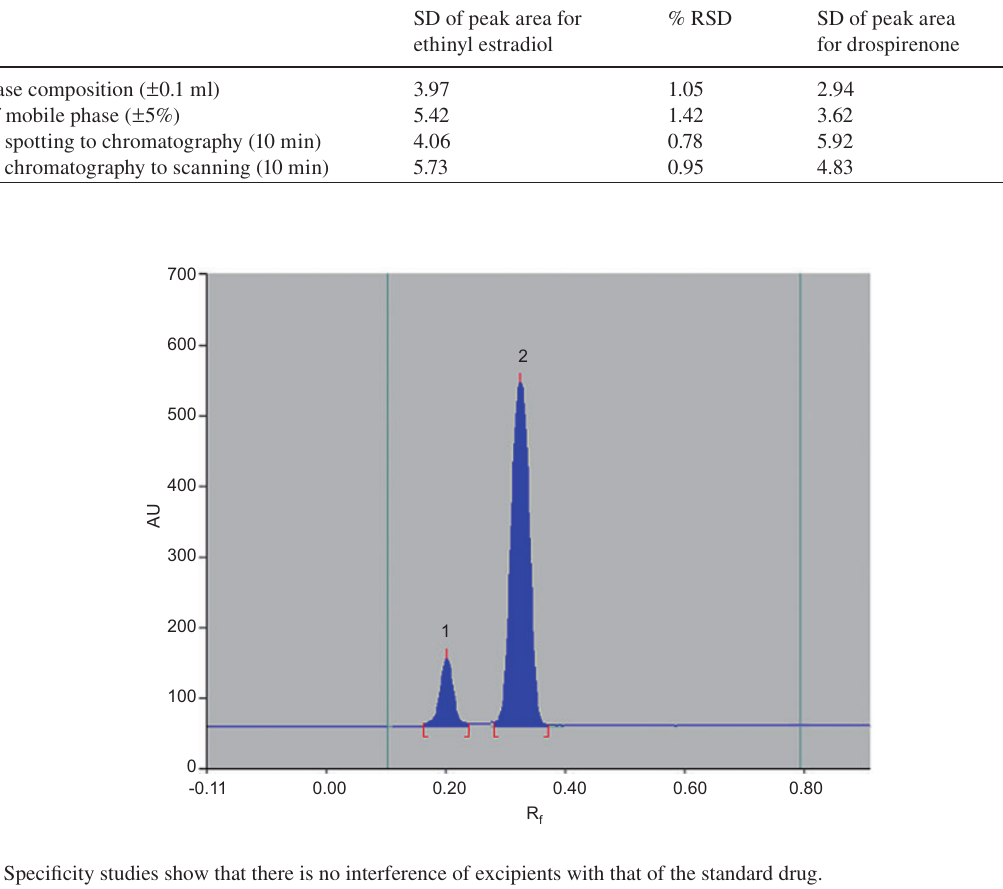
Figure 5 Specifi city studies show that there is no interference of excipients with that of the standard drug.